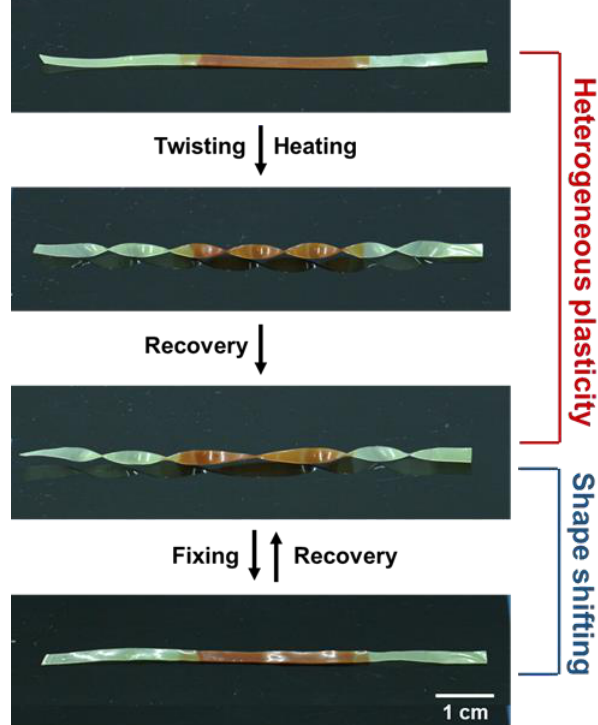
Figure 10. Shape manipulations of a sample with triple blocks.